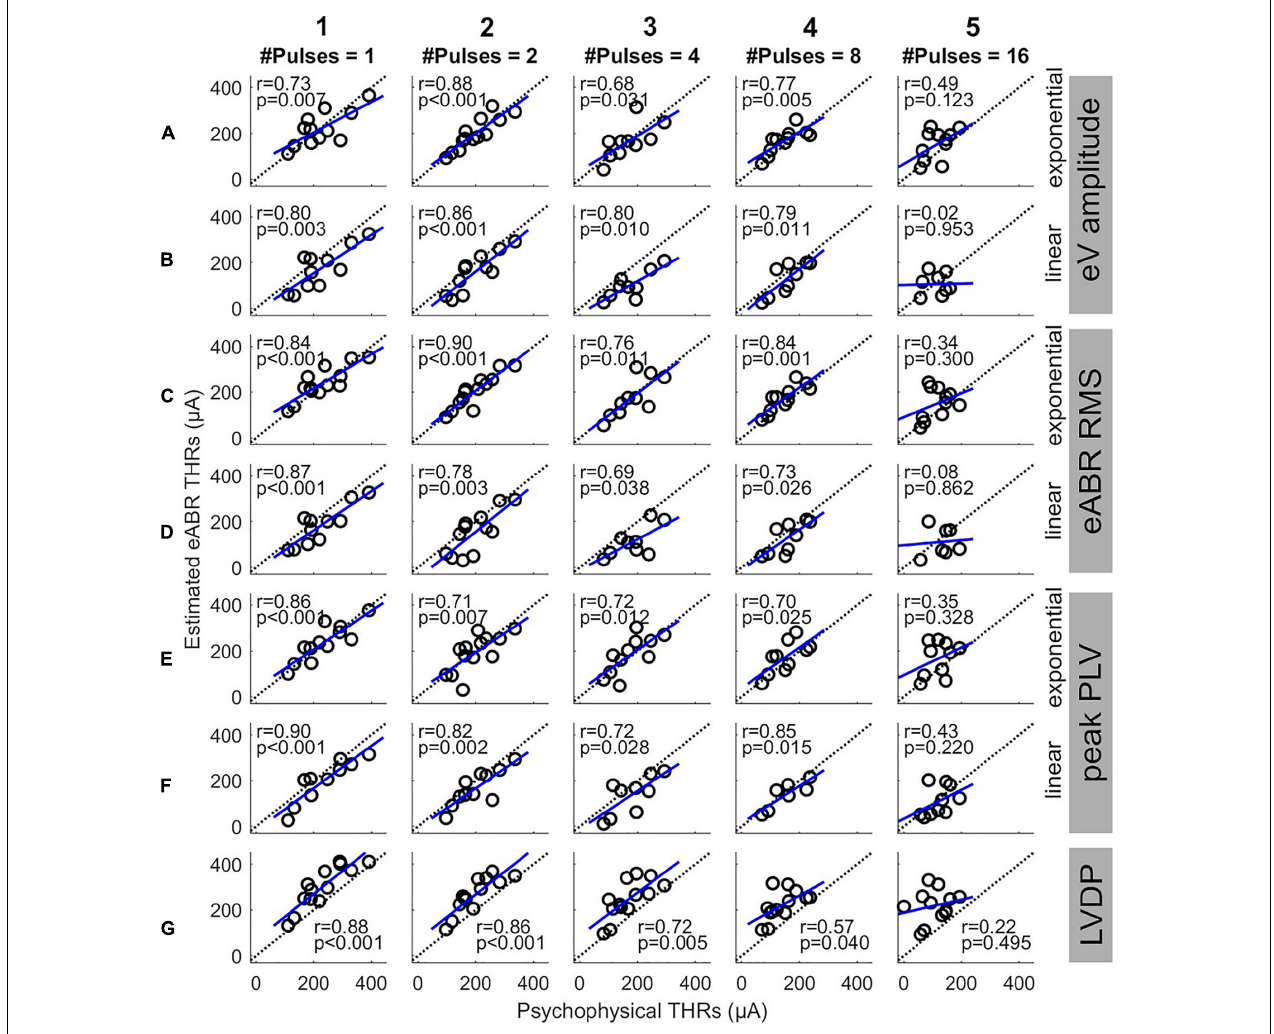
FIGURE 7 | Estimated eABR THRs as a function of psychophysical THRs for multi-pulse conditions. Each column shows results of a specific number of pulses. Panels (A,B) show the eABR THRs estimated from AGFs of wave eV with exponential and linear fittings, respectively. Panels (C,D) present the eABR THRs estimated from growth functions of eABR RMS values with exponential and linear fittings, respectively. Panels (E,F) present the eABR THRs estimated from growth functions of peak PLV with exponential and linear fittings, respectively. Panels (G) show the eABR THRs resulted from the LVDP method. Open circles present data from individual subjects. Dotted black lines show the identity lines and the blue lines show linear regressions. In each panel, the correlation coefficient ( r ) and the probability value ( p ) are